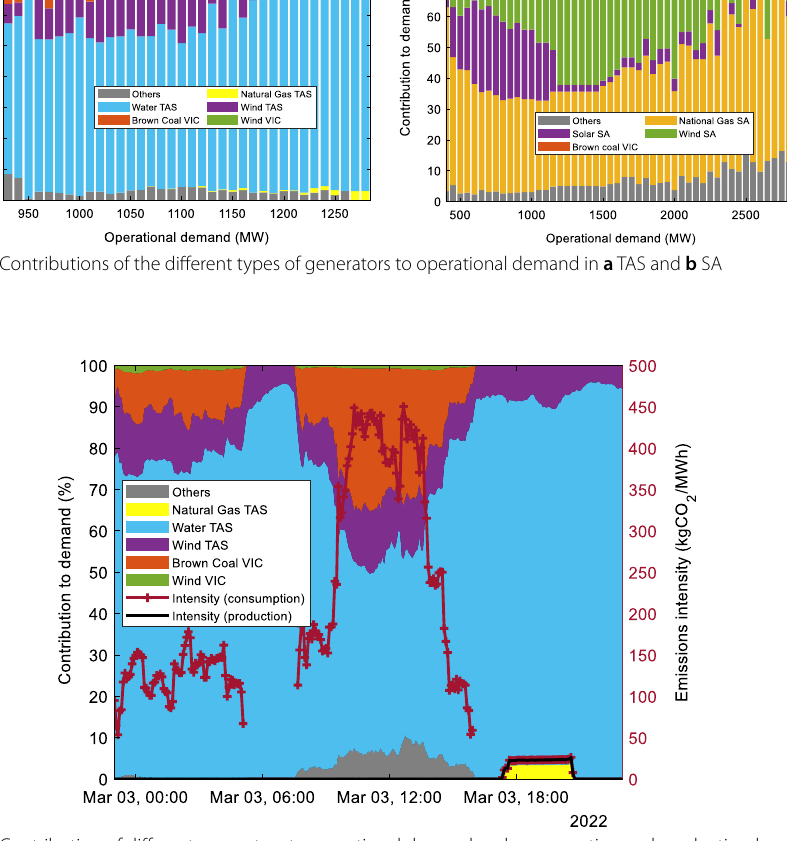
Fig. 8 Contribution of different generators to operational demand and consumption and production-based emissions intensity for TAS on 3 rd March